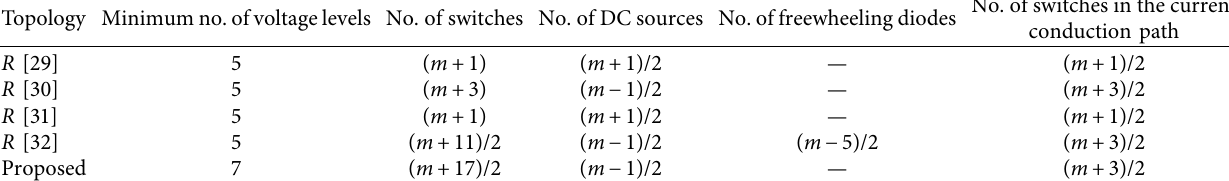
Table 3: Mathematical relations to achieve switching devices and dc sources for “ m ” levels.